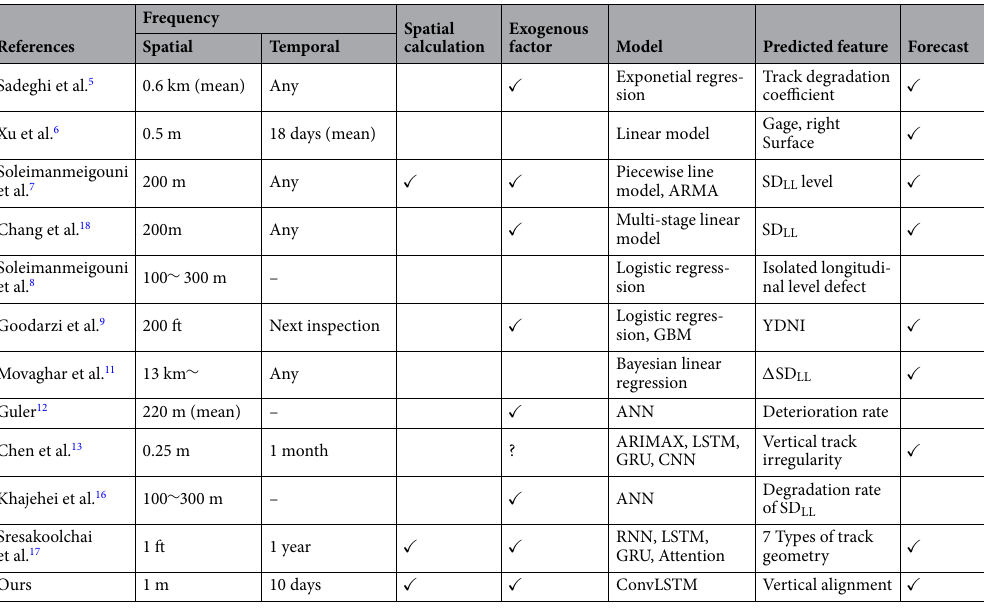
Table 2. Vertical alignment prediction